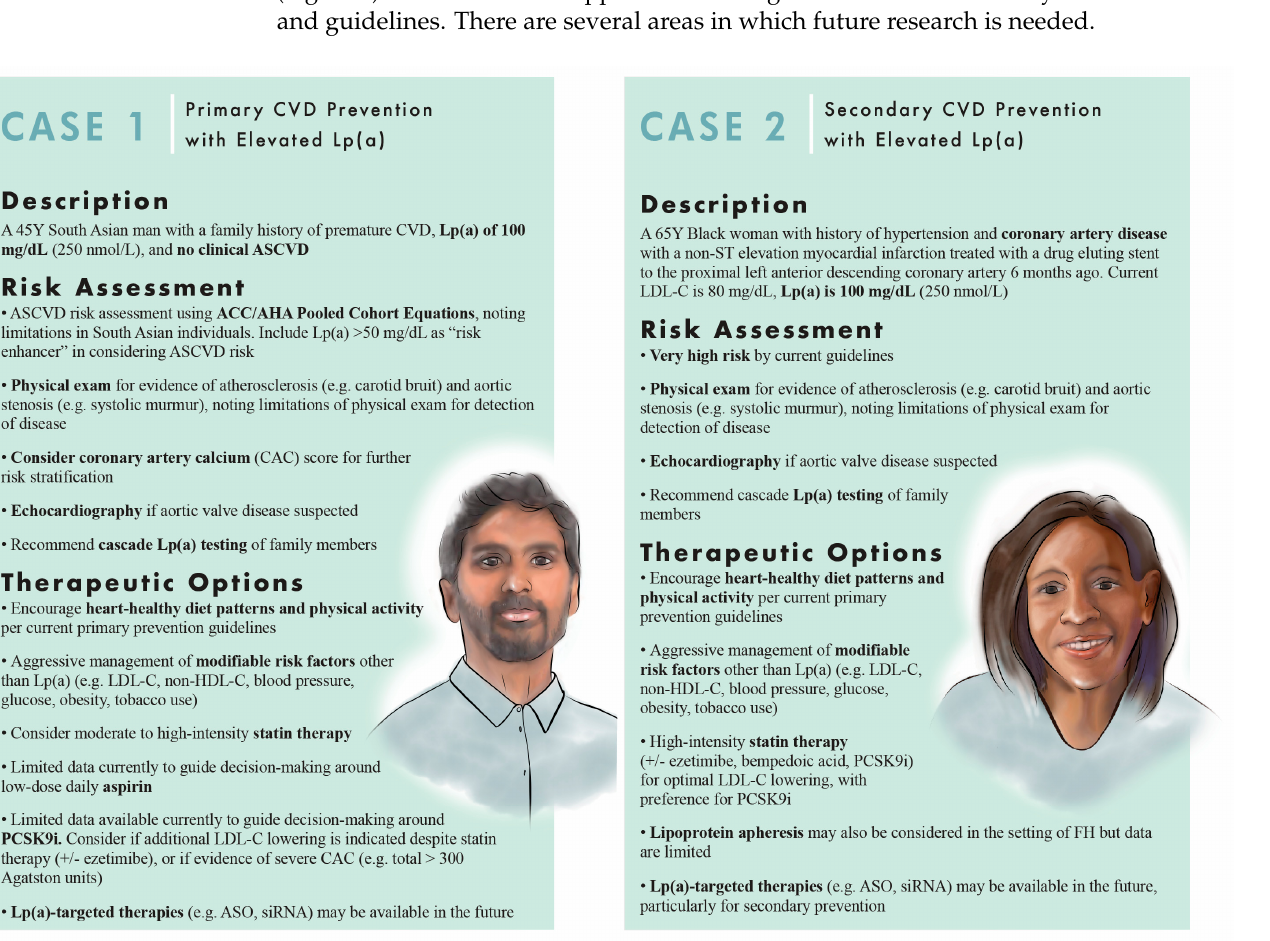
Figure 2. Patient cases: risk assessment and therapeutic options in the setting of elevated Lp(a). Two patient case scenarios are presented above, one for the primary prevention and one for secondary prevention in the setting of elevated Lp(a), with discussion of risk assessment and therapeutic options. For case 1 (primary prevention), the patient evaluation starts with risk assessment using the ACC/AHA Pooled Cohort Equations [19]. Lp(a) ≥ 50 mg/dL is considered a risk enhancer and would be an indication for more aggressive management of risk factors in an individual at borderline or intermediate 10-year risk. A physical exam is important to evaluate for evidence of atherosclerosis or aortic stenosis. If aortic valve disease is suspected, echocardiography would be indicated. CAC scoring can be considered to further risk stratify [20,22]. Cascade Lp(a) testing may be recommended for family members [104,105]. With regards to therapy, a healthy lifestyle should be recommended to all patients [19,106]. In the setting of elevated Lp(a), other modifiable risk factors should be addressed, and moderate to high-intensity statin therapy should be consid- ered. Low dose daily aspirin may be a consideration, but there is currently limited data to guide this decision. Similarly, there is limited date for PCSK9i, but they may considered, particularly if additional LDL-C lowering is needed despite statin therapy, or there is evidence of severe CAC. Lp(a)-targeted therapies may be available as an option in the future. For case 2 (secondary preven- tion), the patient is considered very high risk by current guidelines [20]. Again, physical exam is important, and echocardiography is indicated if there is suspicion for aortic valve disease. Cascade Lp(a) testing may also be recommended for family members. Regarding therapy, a healthy life- style and management of other risk factors are again recommended. High intensity statin therapy should be prescribed, with consideration of PCSK9i if further LDL-C lowering needed [20,22]. Lipoprotein apheresis may be considered in the setting of FH [107]. Lp(a)-targeted therapies may also be an option in the near future, particularly for secondary prevention. For secondary prevention of CVD, the biggest area of controversy is whether Lp(a)- lowering translates to reduced risk of ASCVD events, and what degree of Lp(a)-lowering is necessary to achieve this effect. Lp(a)HORIZON (NCT04023552) is currently underway and will evaluate the effect of potent Lp(a)-lowering with pelacarsen in the setting of